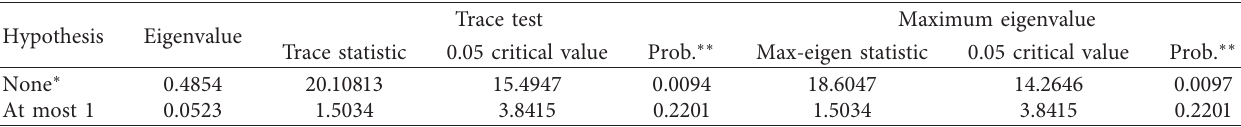
Table 8: Johansen cointegration test results.